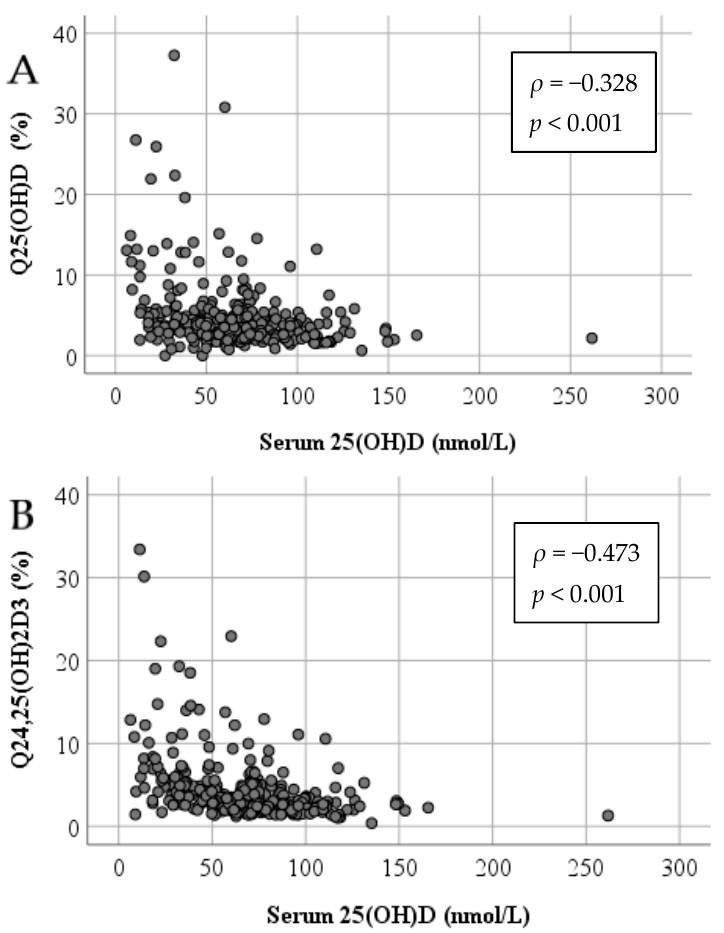
Figure 1. Correlations (Spearman’s ρ ) between the serum concentration of 25(OH)D and the CSF/serum ratios of ( A ) 25(OH)D (Q 25(OH)D ) and ( B ) 24,25(OH) 2 D 3 (Q 24,25(OH)2D3 ) expressed as percent.